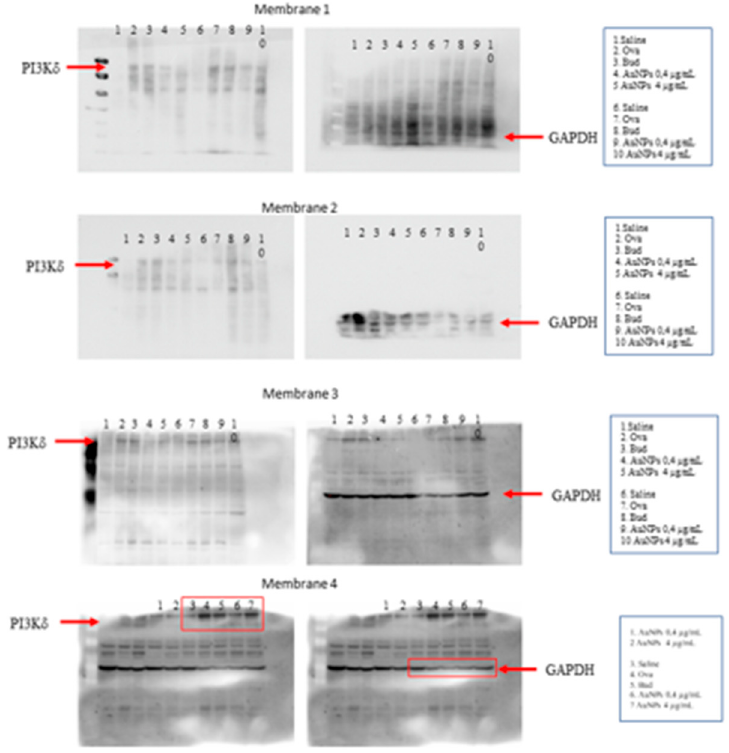
Figure A5. Upload of full gels for all Western blot images used to quantify PI3K δ as shown in Figure 6A. Red rectangles indicate lanes presented as representative blots in Figure 6A.